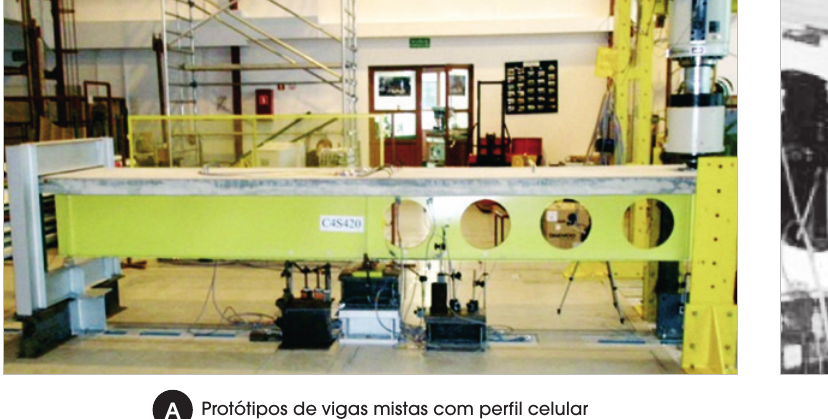
A Protótipos de vigas mistas com perfil celular Figura 7 Experimentos em vigas mistas com perfil celular [12]